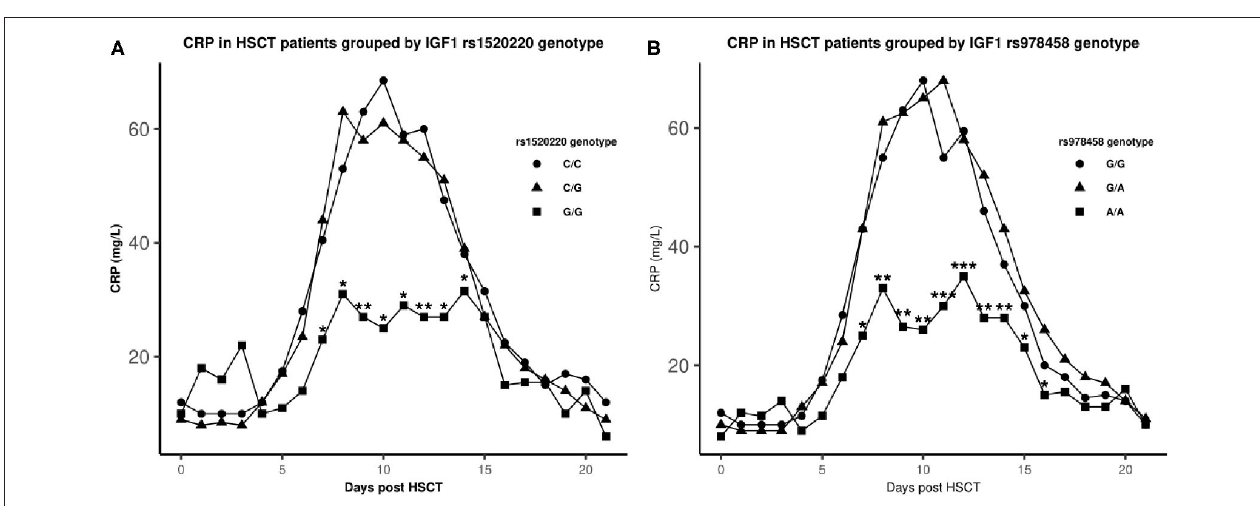
FIGURE 3 | Median CRP levels after HSCT in genotype groups. N : homozygous major allele, •: heterozygous, (cid:4) : homozygous minor allele. *statistical difference in CRP levels between the homozygote minor allele genotype and the other genotypes ( P ≤ 0.04). ** P < 0.01, *** P < 0.001. Genotype distribution: rs1520220: C/C: n = 361, C/G: n = 160, G/G: n = 21 and rs978458: G/G: n = 297, G/A: n = 213, A/A: n =